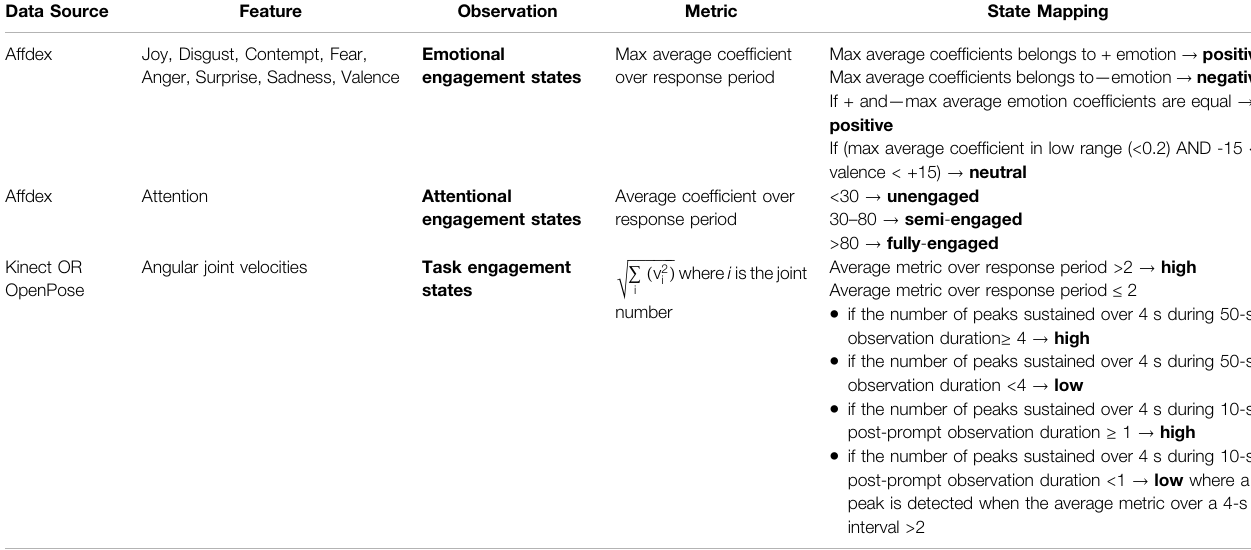
TABLE 1 | A summary of the mappings between the detected behavioral features and the state values we de fi ned for our model. Data